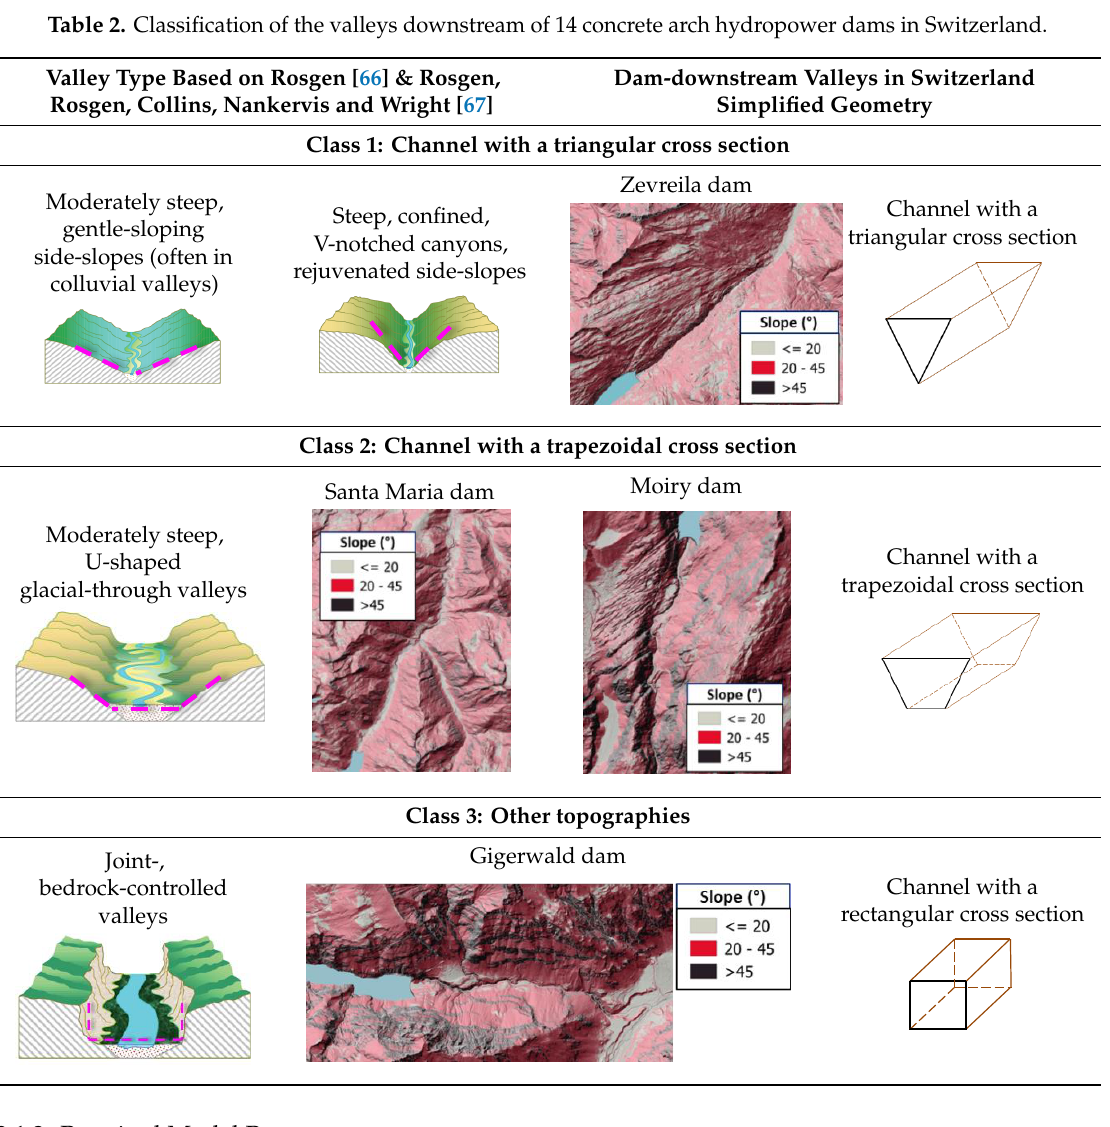
Table 2. Input parameters for the model of the flood wave propagation resulting from a concrete dam